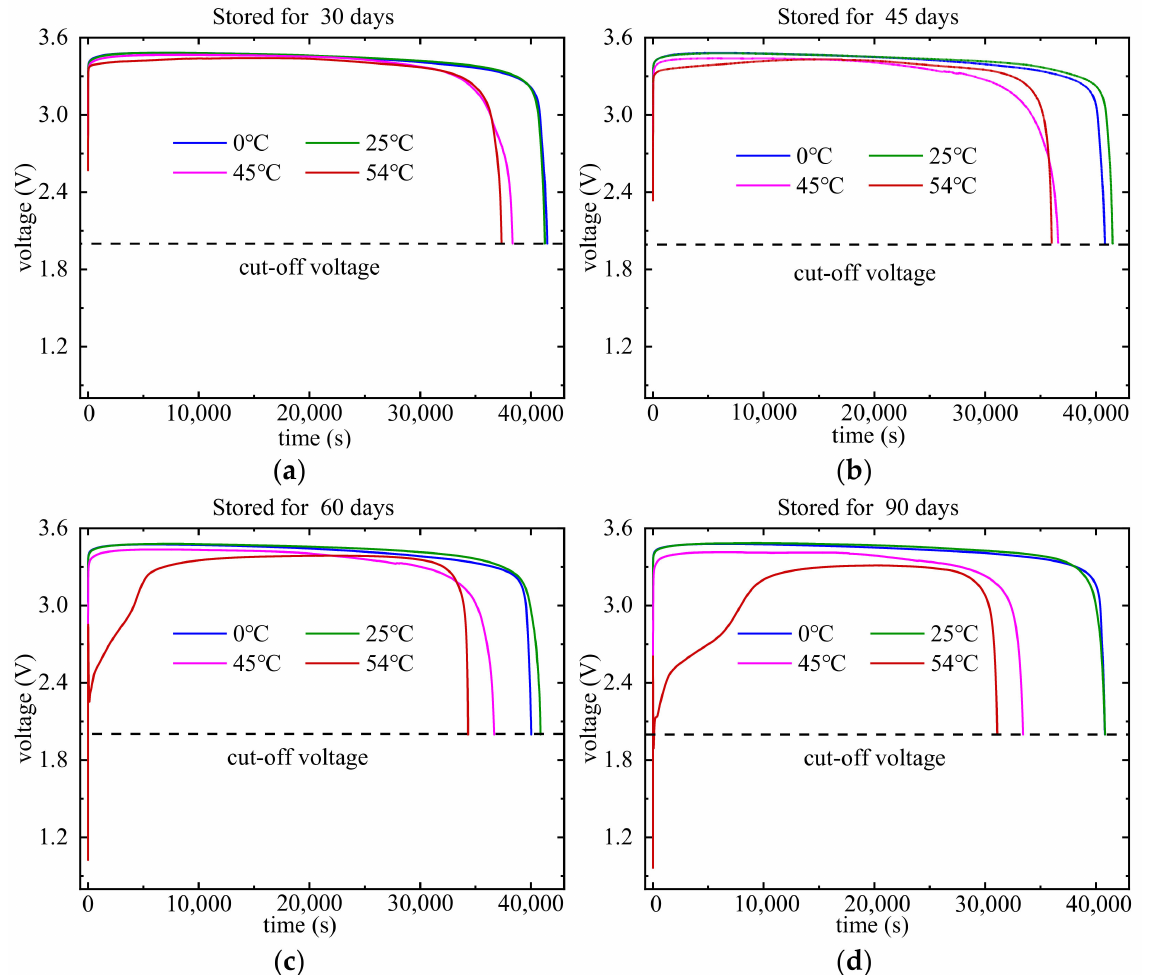
Figure 4. The discharge voltage curves of batteries stored at different temperatures for ( a ) 30 days; ( b ) 45 days; ( c ) 60 days; and ( d ) 90 days.